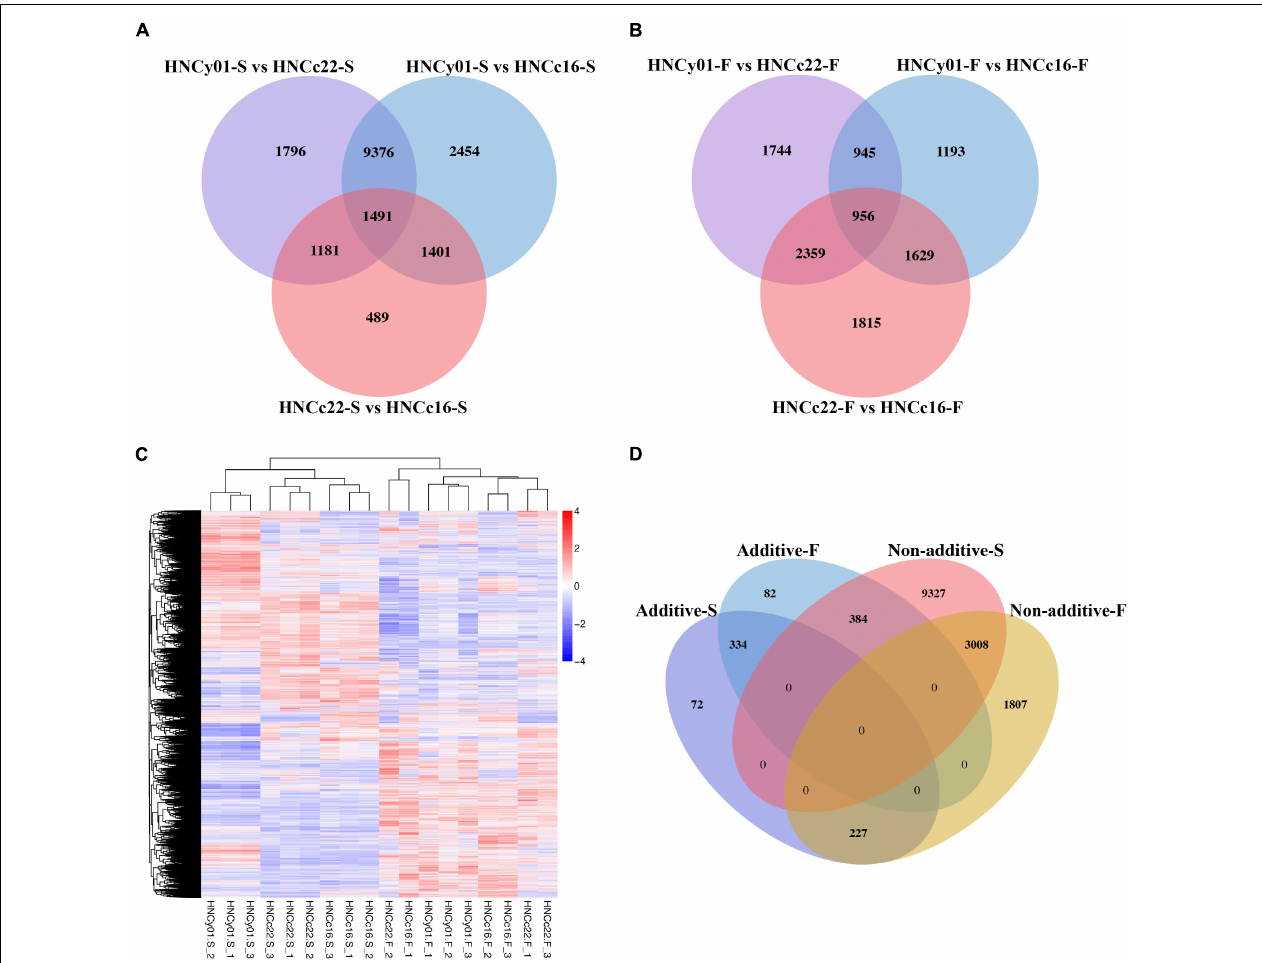
FIGURE 2 | Differential expression between the hybrid and its parents at the two development stages. (A) S-stage and (B) F-stage. (C) Heatmap and cluster analysis of expression level of DEGs. (D) Comparison of additive and non-additive genes in the hybrid at the S-stage and F-stage.